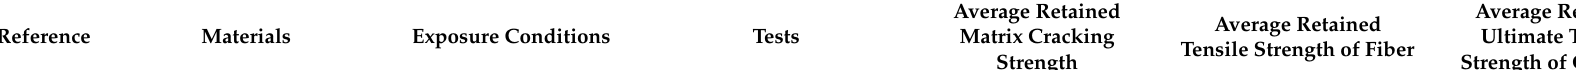
Table A1. E ff ects of the ageing environments on the matrix, fabric, coupon, and composite–substrate retained